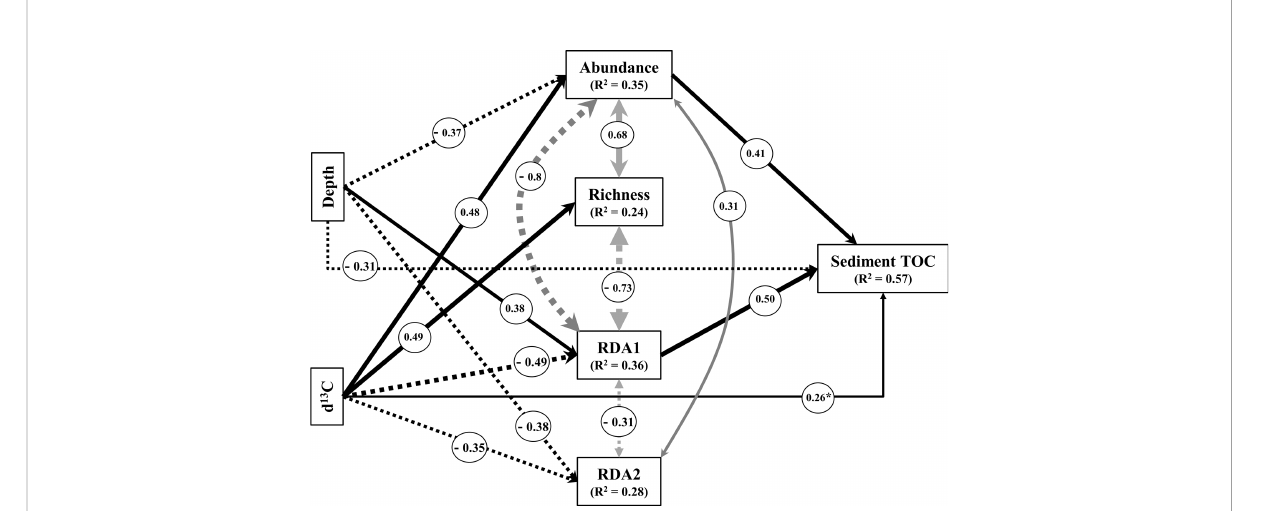
FIGURE 4 Most parsimonious structural equation model (Fisher ’ s C statistic = 6.1, p = 0.64), depicting the causal link between sediment organic carbon, depth and diatom community structure and composition. Black arrows represent unidirectional relationships among variables and grey arrows non-causal correlations. Solid and dashed arrows denote positive and negative relationships, respectively. The thickness of the paths is scaled based on the magnitude of path coef fi cient ( b ). The R 2 value indicates the amount of variance explained by the model. The fi nal model included only signi fi cant and almost signi fi cant R 2 values (0.05 > p< 0.1; indicated by * pathways). RDA = redundancy